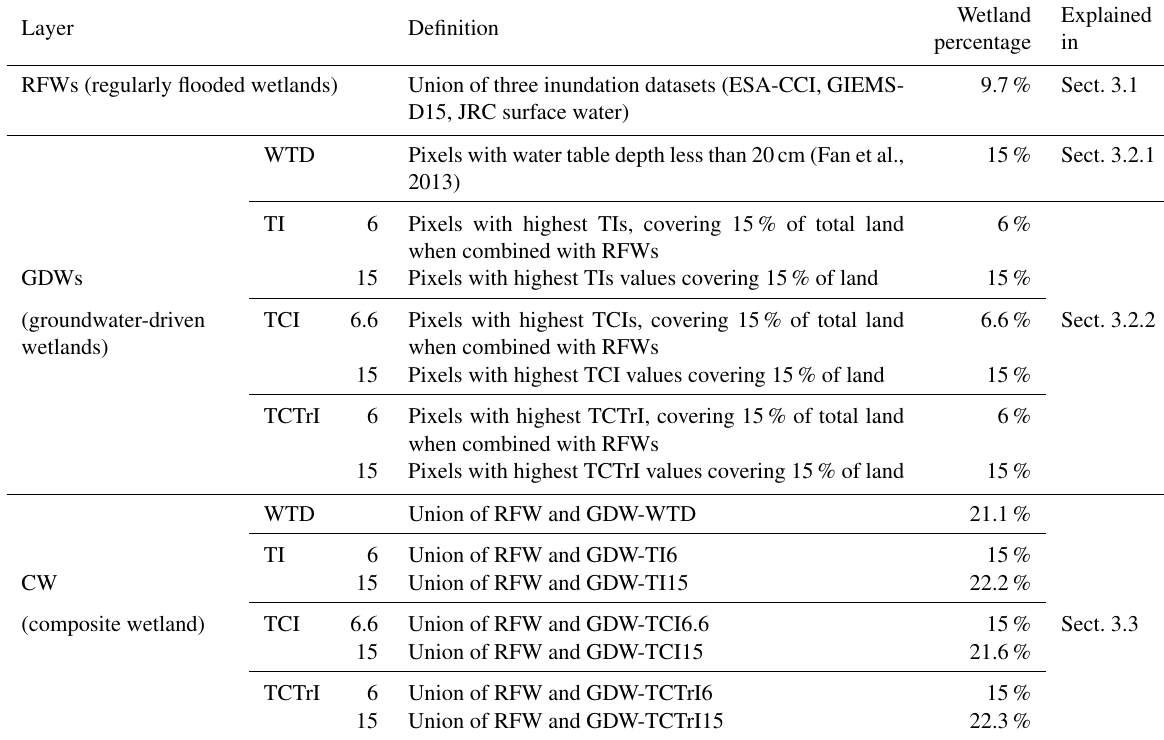
Table 2. Layers of wetlands constructed in the paper, their definitions and the subsections in which they are explained. The total land area for wetland percentages excludes lakes, Antarctica and the Greenland ice sheet. Wetland Explained Layer Definition percentage in RFWs (regularly flooded wetlands) Union of three inundation datasets (ESA-CCI, GIEMS- D15, JRC surface water) WTD Pixels with water table depth less than 20cm (Fan et